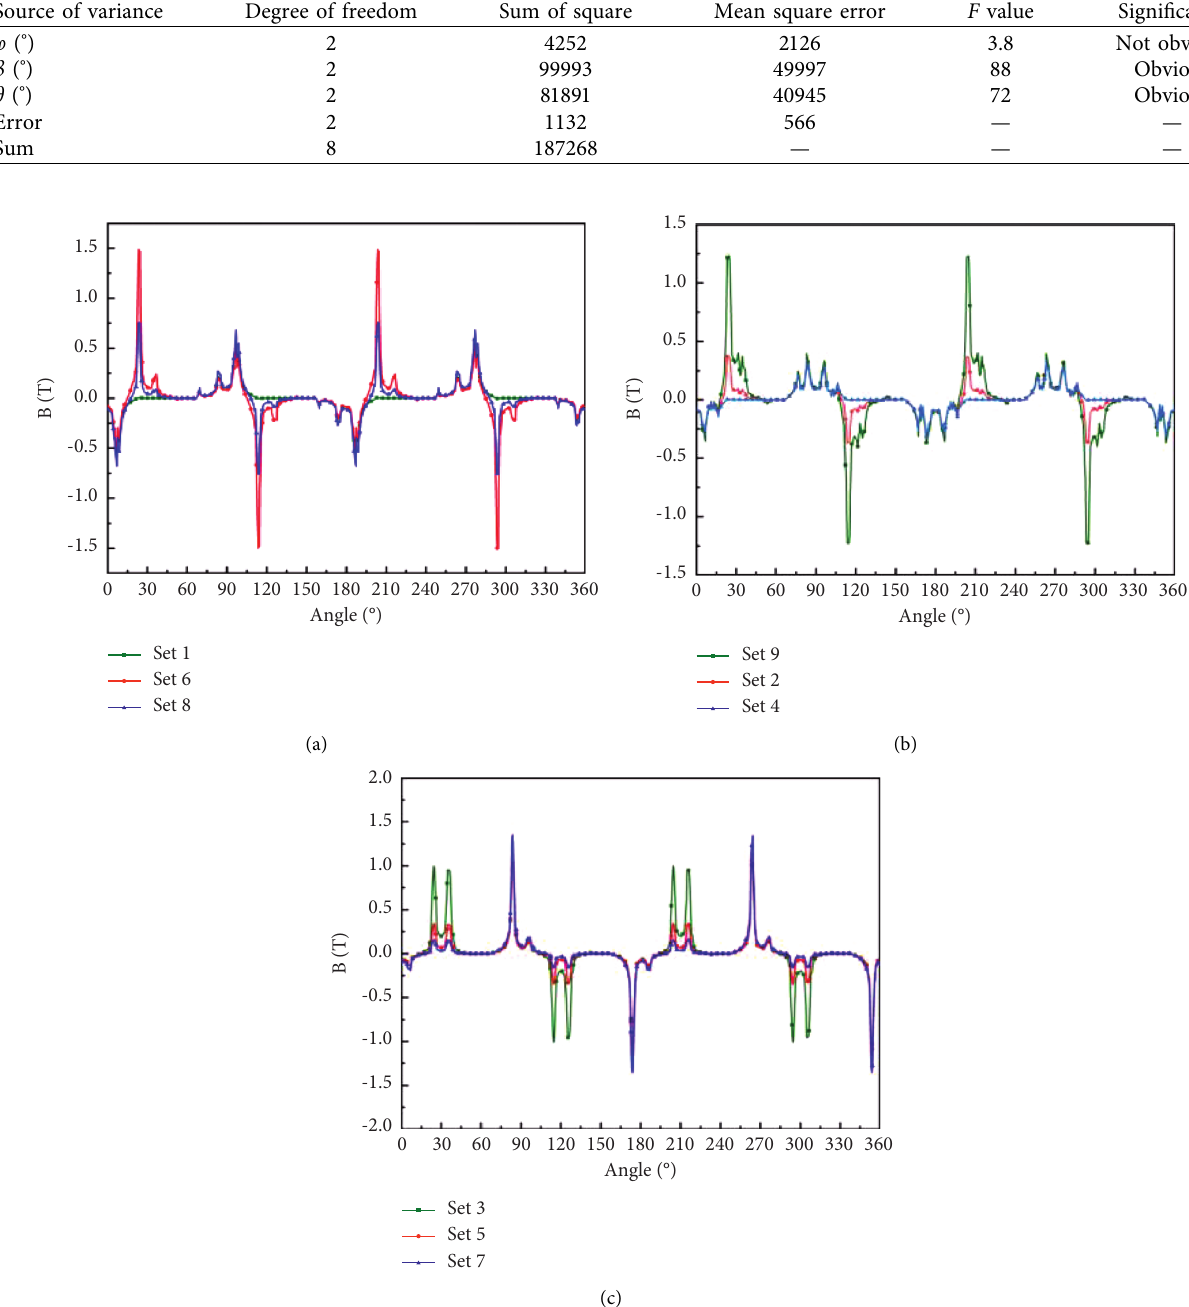
Figure 7: Radial magnetic density versus initial position for different parameter sets. (a) θ � 7 . 5 ° . (b) θ � 15 ° . (c) θ � 22 . 5 °